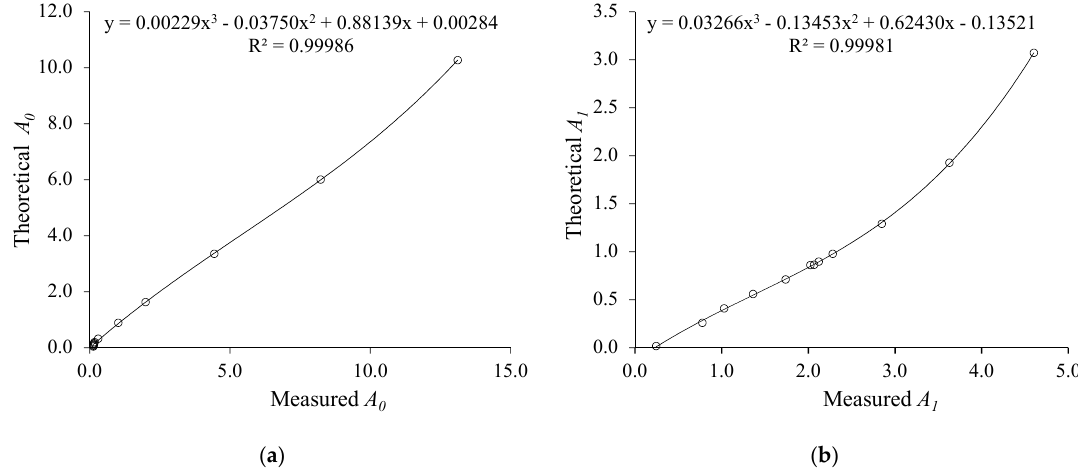
Figure 6. ( a ) Measured and theoretical A 0 relationship; ( b ) Measured and theoretical A 1 relationship.